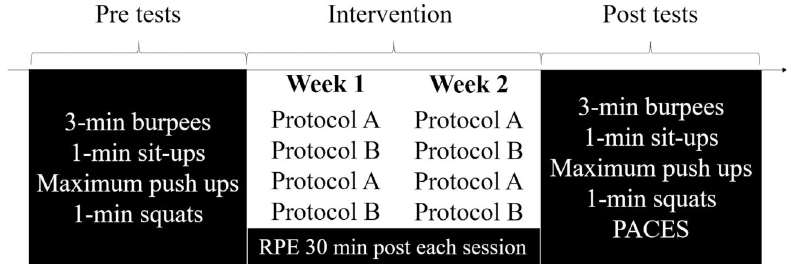
Figure 1 - Study design. Legend: RPE = Rating of Perceived Exertion (Borg’s scale). PACES = Physical Activity Enjoyment